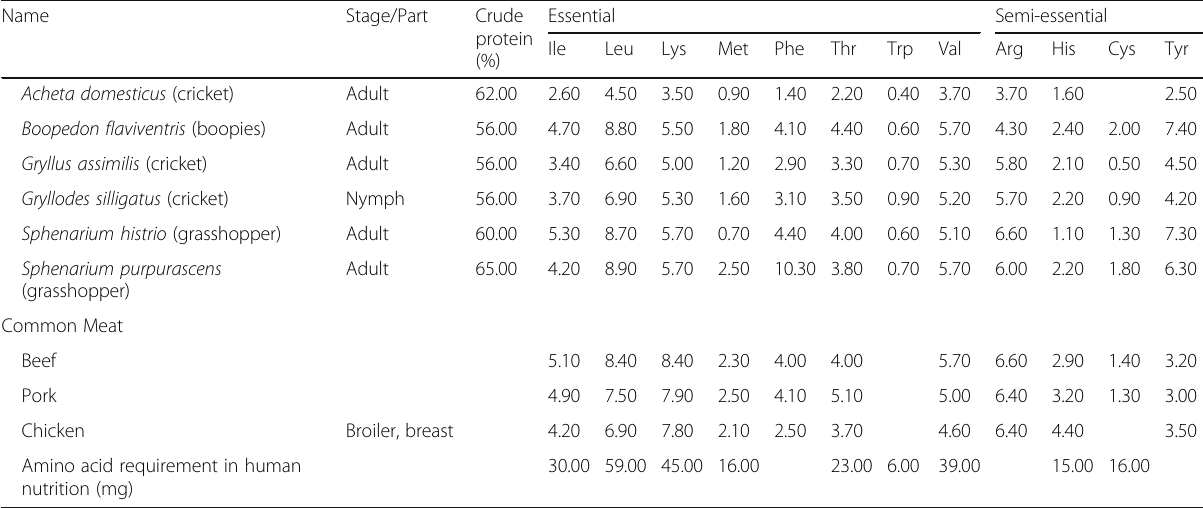
Table 1 Amino acid content of common edible insects (% in crude protein of dry weight)